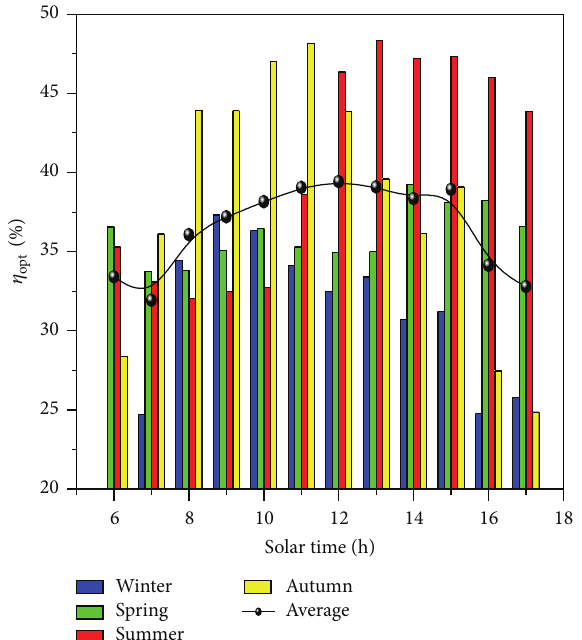
Figure 14: The hourly distribution of the optical efficiency, 𝜂 TLSC (Riyadh-2011).